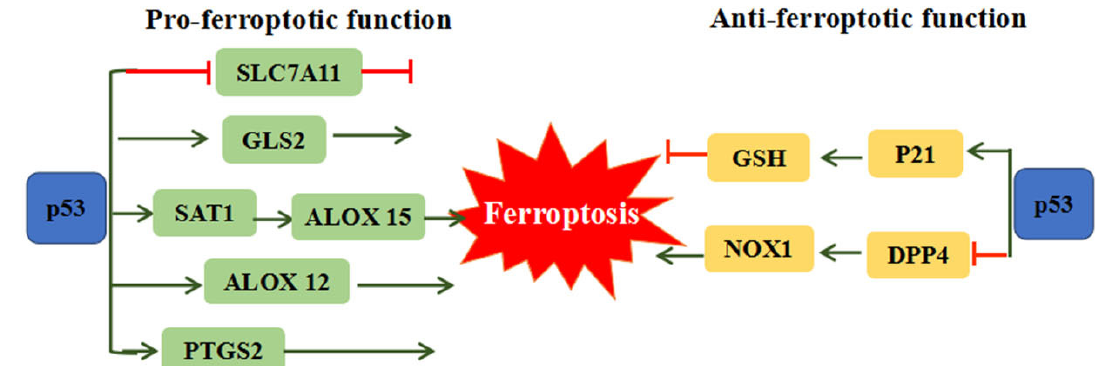
Figure 2. The dual function of p53 on ferroptosis. P53 can promote ferroptosis through regulating SLC7A11, GLS2, SAT1/ALOX15, ALOX12 and PTGS2. Meanwhile, p53 also could restrain ferroptosis via the mediation of p21 and DPP4. ALOX12: Arachidonate 12-Lipoxygenase, ALOX15: Arachidonate 15-Lipoxygenase, DPP4: Dipeptidyl peptidase 4, GLS2: Glutaminase 2, SLC7A11: Solute carrier family 7 member 11, SAT1: Spermidine/spermine N1-acetyltransferase 1.